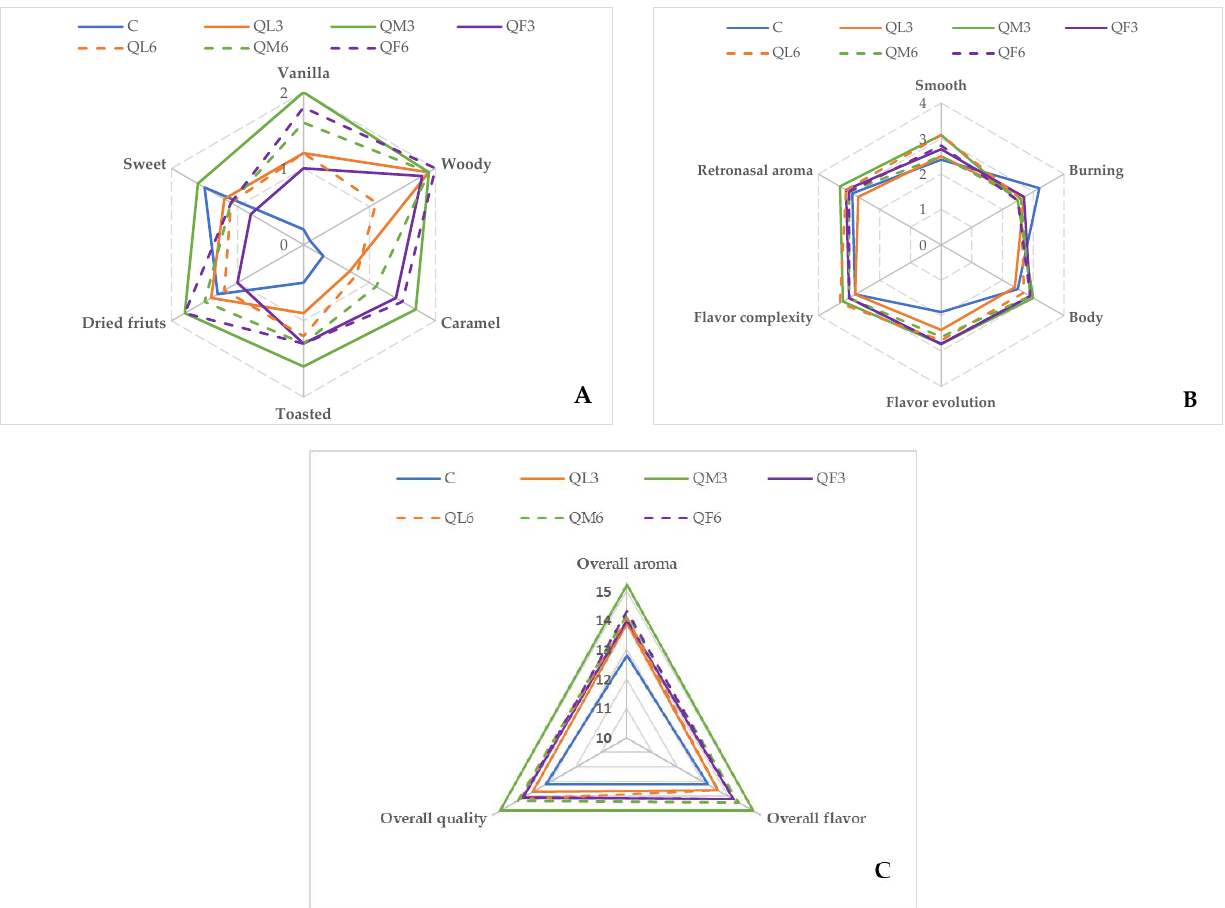
Figure 3. Olfactory ( A ), gustatory ( B ) and overall quality ( C ) profiles based on the average panel attributes scores of the AUS.